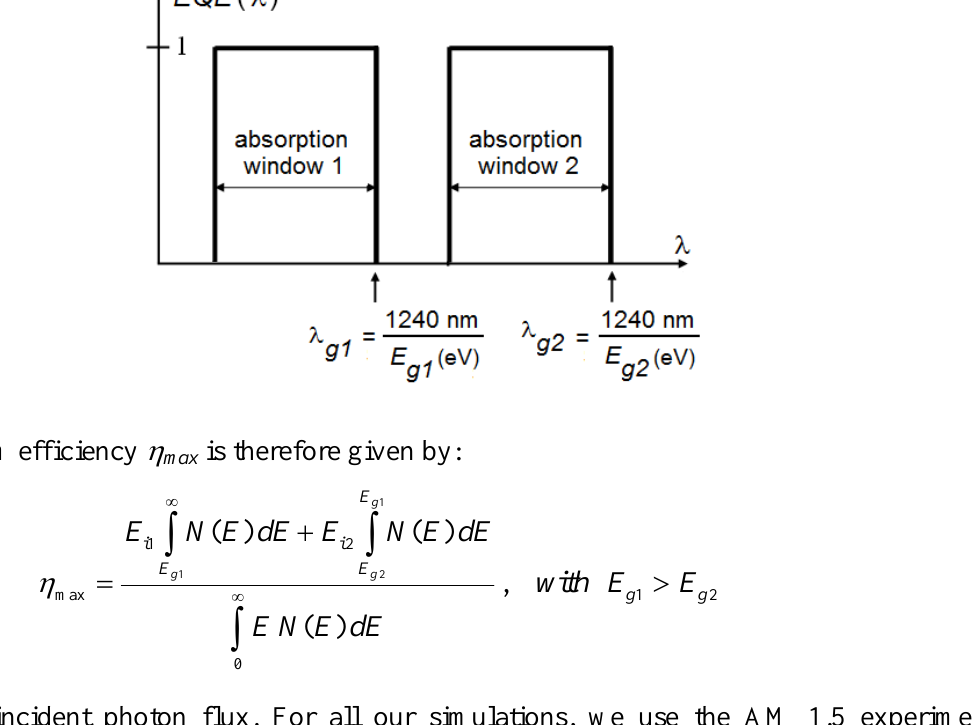
. Notice that the order of the first g